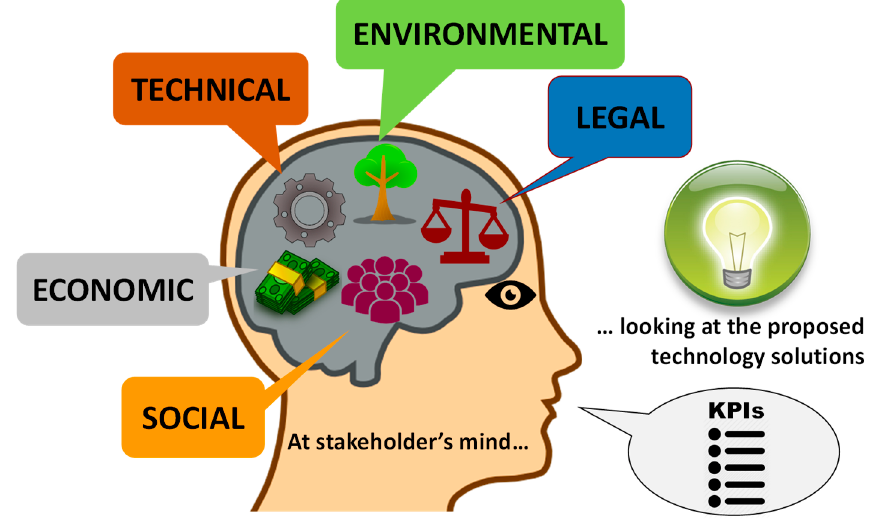
Figure 2. KPI determination depiction considering each stakeholder viewpoint.